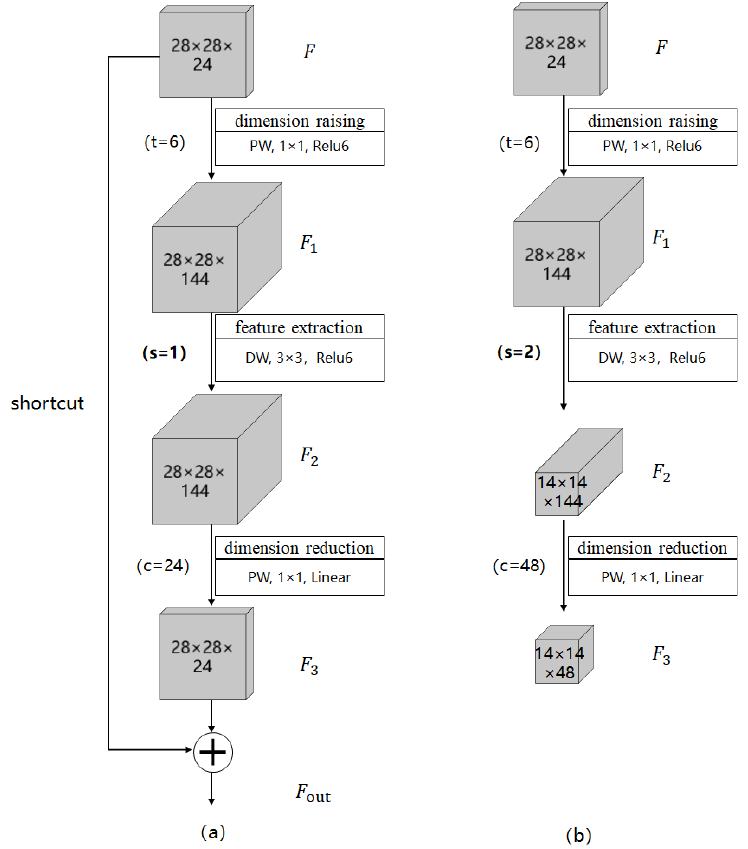
Figure 6. The schematic diagram of the bottleneck structure. ( a ) With the shortcut connection, ( b ) Without the shortcut connection.